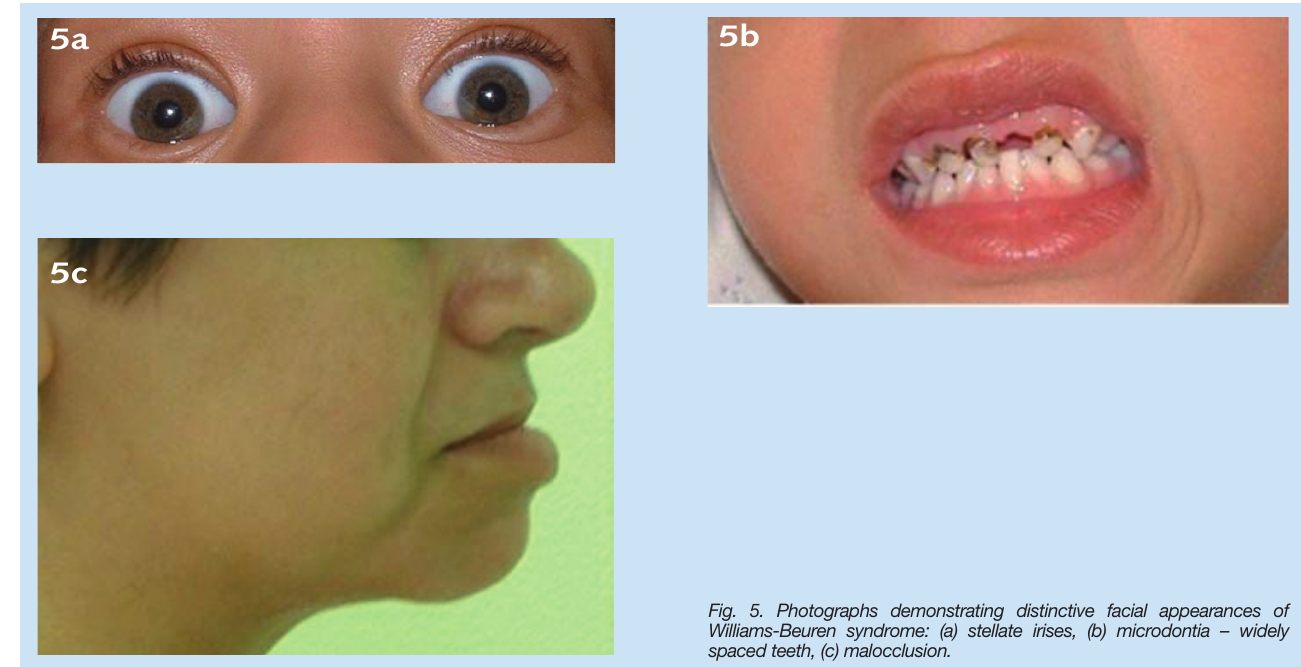
Fig. 5. Photographs demonstrating distinctive facial appearances of Williams-Beuren syndrome: (a) stellate irises, (b) microdontia – widely spaced teeth, (c)